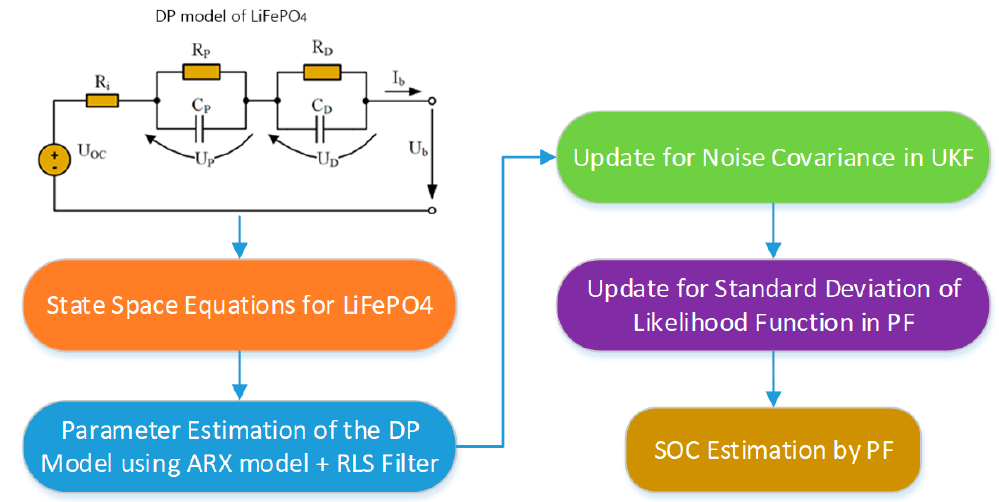
Figure 1. Proposed method block diagram for LiFePO 4 (LPF) Battery.